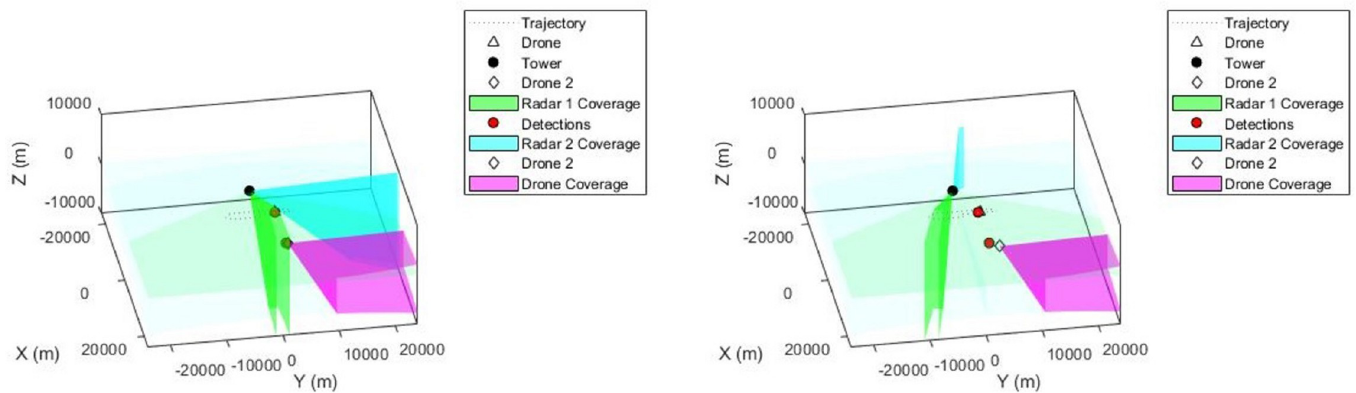
Fig 5. ( a ) Intrusion of second drone into the safety zone. Flying from southwest to northeast at a height of 1.5 km with a time of arrival [0 80]; ( b ) The second drone remain trackable. As its moves, its detection moves as well. https://doi.org/10.1371/journal.pone.0268834.g005 the band. Lasty, the system model performance has been tested as a series of states spaces model, to validate the model with real world. Based on time invariant, the simulate states and observations were estimated. As shown in Fig 8, the true state and simulated states of the target